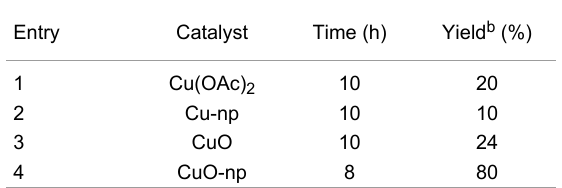
Table 1: C-arylation reaction catalyzed by different Cu catalysts a